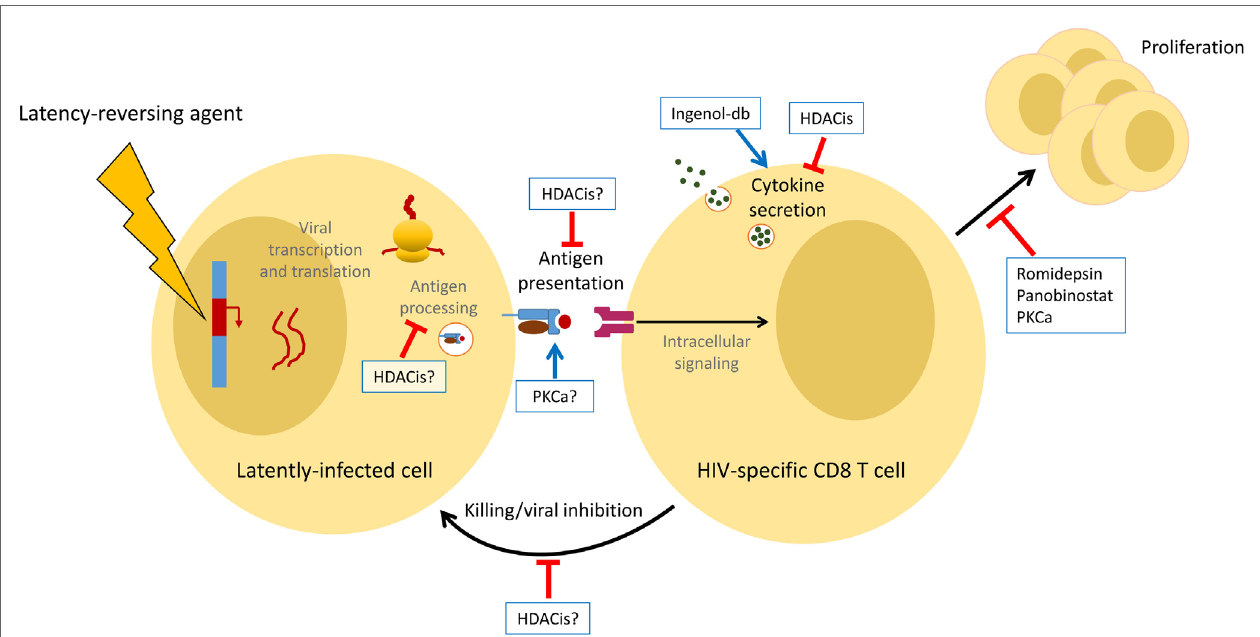
FigURe 1 | Summary of the effects of latency-reversing agents (LRAs) on antigen-specific CD8 + T-cells in vitro . LRAs can either enhance (blue arrows) or inhibit (red bars) multiple facets of the CD8 + T-cell response. Some of these observations have yet to be confirmed by clinical